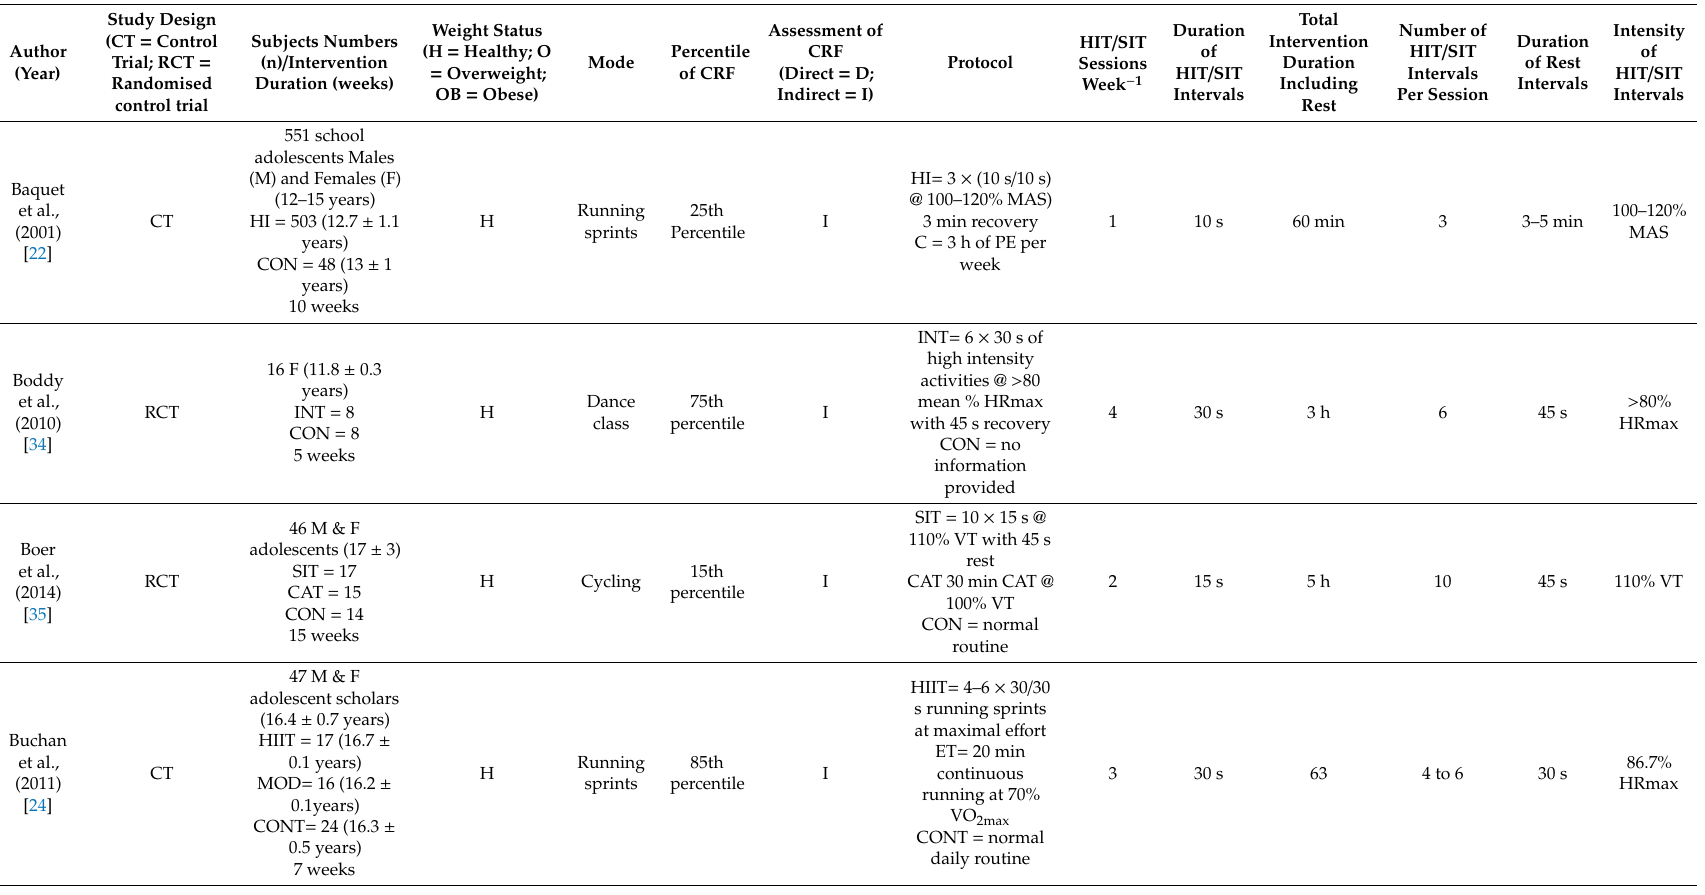
Table 2. Description of high intensity interval training (HIIT) / sprint interval training studies (SIT) in